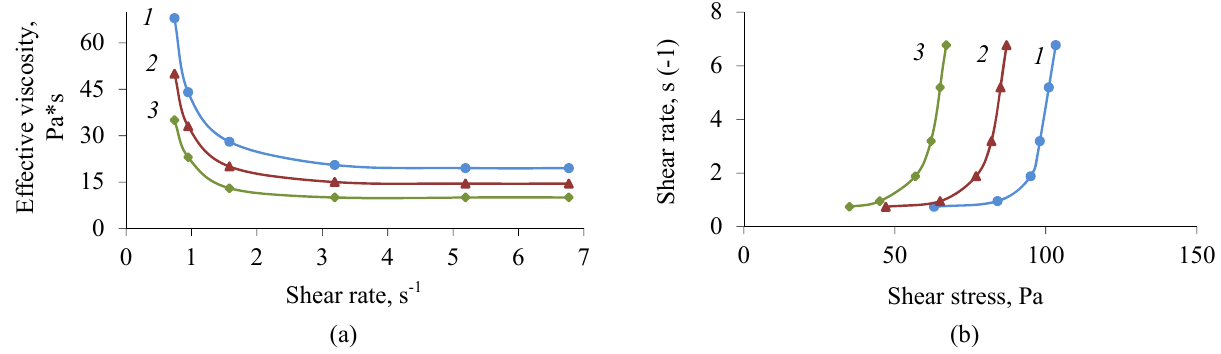
Fig. 6. Dependence of the effective viscosity of jelly mass based on pectin on the shear rate (a) and flow curves (b) at t = 70°C of the jelly mass based on pectin: ( 1 ) molasses + sugar + apple puree (control); ( 2 ) stevioside + apple puree; ( 3 ) stevioside + apple puree + juice from sea buckthorn berries + concentrated apple